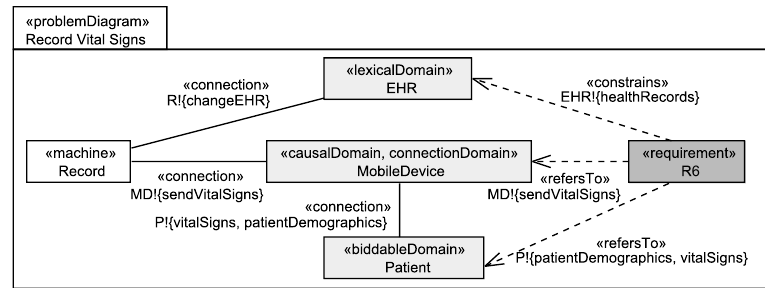
Figure 2. Problem diagram for functional requirement